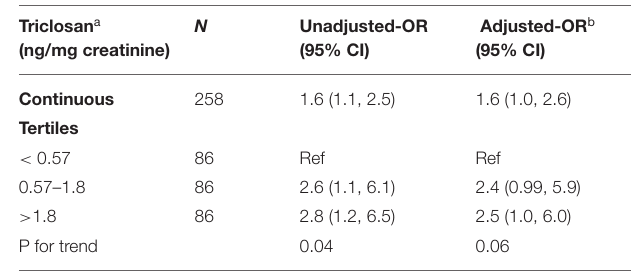
TABLE 2 | Fecundability odds ratios for triclosan exposure using the Cox model modified for discrete time data.